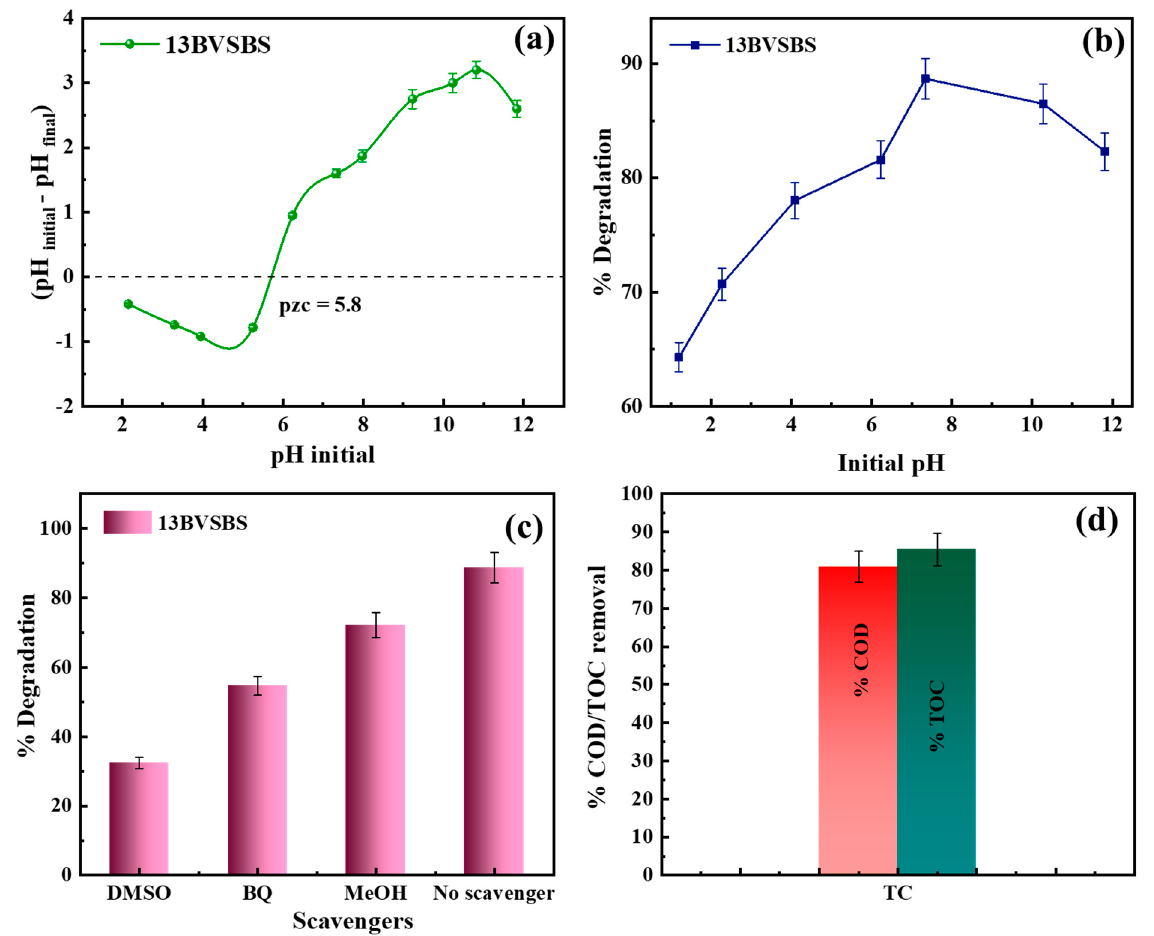
Figure 6. ( a ) pzc of the 13BVSBS nanocomposite, ( b ) impact of pH on the degradation efficiency of the 13BVSBS photocatalyst, ( c ) impact of different scavengers on the removal efficacy of the TC, and ( d ) COD and TOC analysis of a commercial sample of TC.